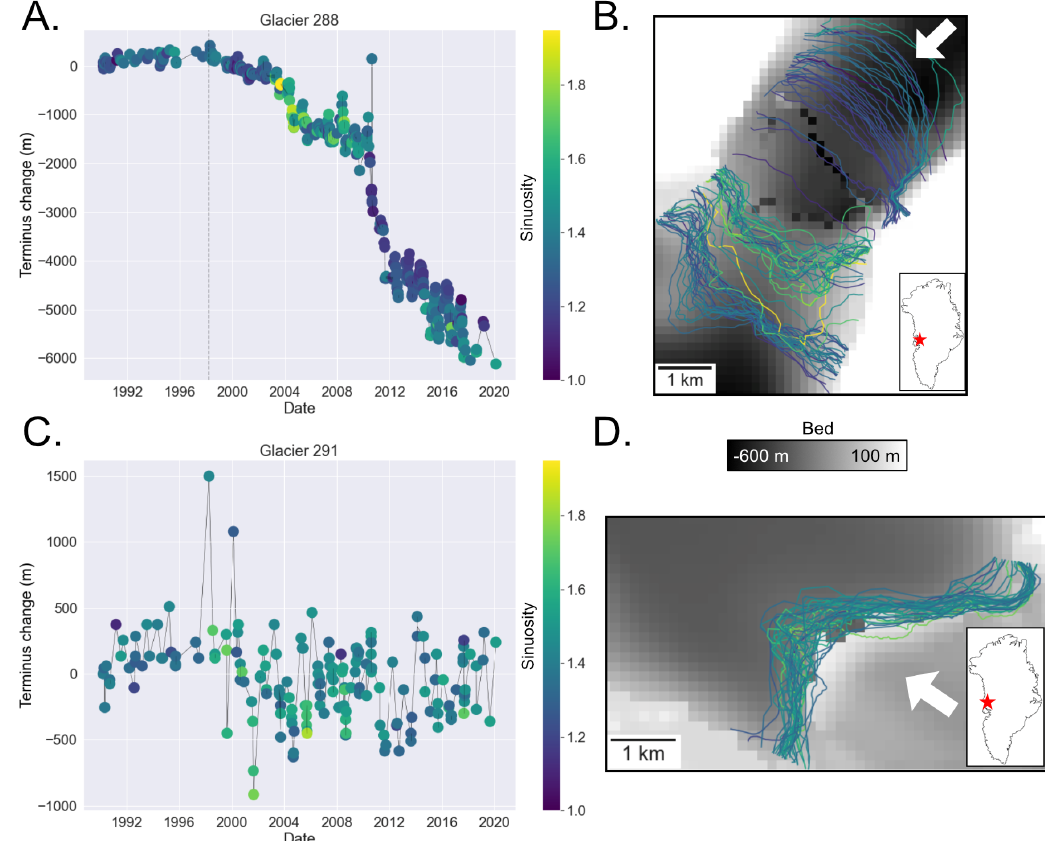
Figure 10. (a) Terminus change between 1990 and 2020 colored by sinuosity for Glacier 288 (Sermeq Silarleq). The dashed grey line is the start of progressive retreat as defined in Catania et al. (2018). (b) Corresponding map-view terminus traces for Glacier 288 with every fifth trace colored by sinuosity. (c) Terminus change between 1990 and 2020 colored by sinuosity for Glacier 291. (d) Corresponding map-view terminus traces for Glacier 291 (Kangerdlugssup Sermerssua) with every fifth trace colored by sinuosity. The base map in (b) and (d) is the bed from BedMachine (Morlighem et al., 2017a). The black pixels in (b) are errors; however, they do not impact the overall interpretation of the bed. The bed scale bar applies to both (b) and (d) . The white arrows indicate glacier flow direction. The red star in the inset map is the location of the glacier on the Greenland Ice